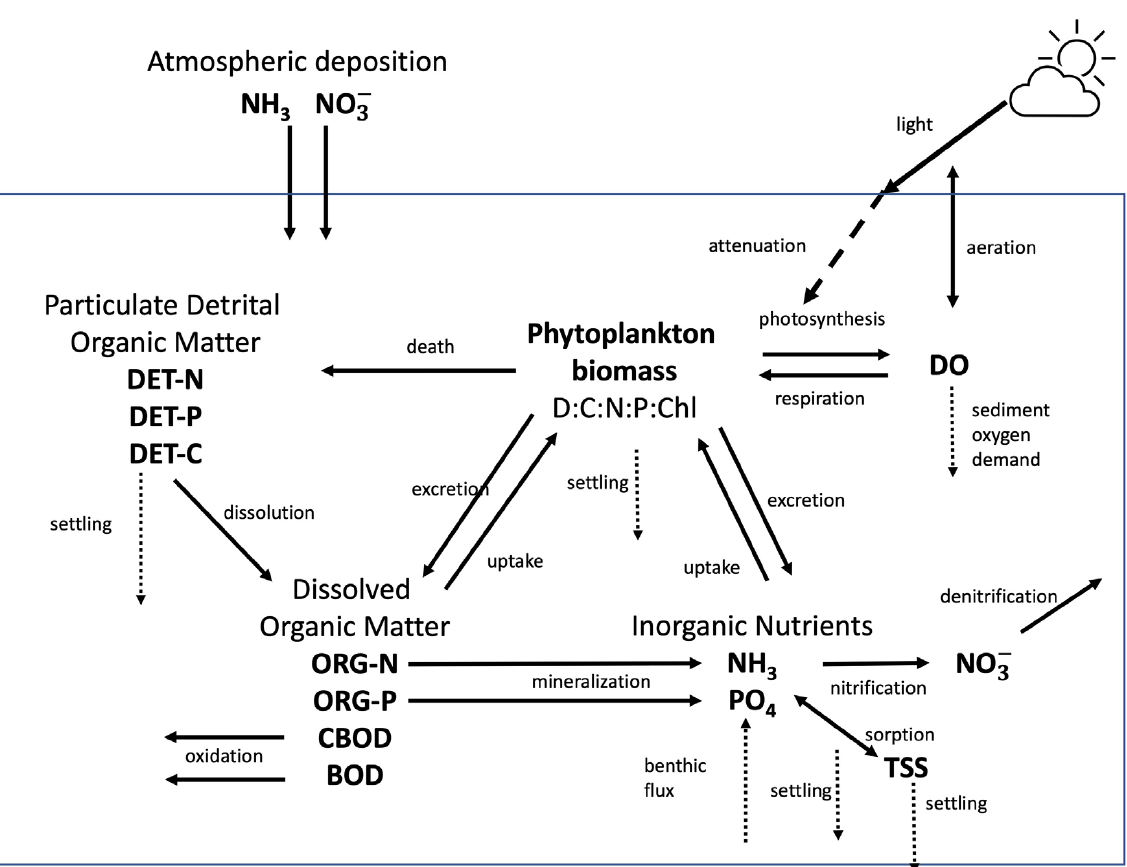
Figure 3. Nutrient Cycling Processes and Simulated State Variables in Narragansett Bay WASP Model. The 15 state variables are presented in bold: nitrate/nitrate (represented as nitrate, NO − ammonia (NH 3 ), inorganic phosphorous (PO 4 ), detrital-N, detrital-P, detrital-C, organic-N, organic-P, CBOD, BOD, dissolved oxygen (DO), total suspended solids (TSS), and phytoplankton. Processes are represented with arrows showing direction of the process. Dotted lines represent state variables interaction with the sediments, including settling, sediment oxygen demand, and benthic flux.